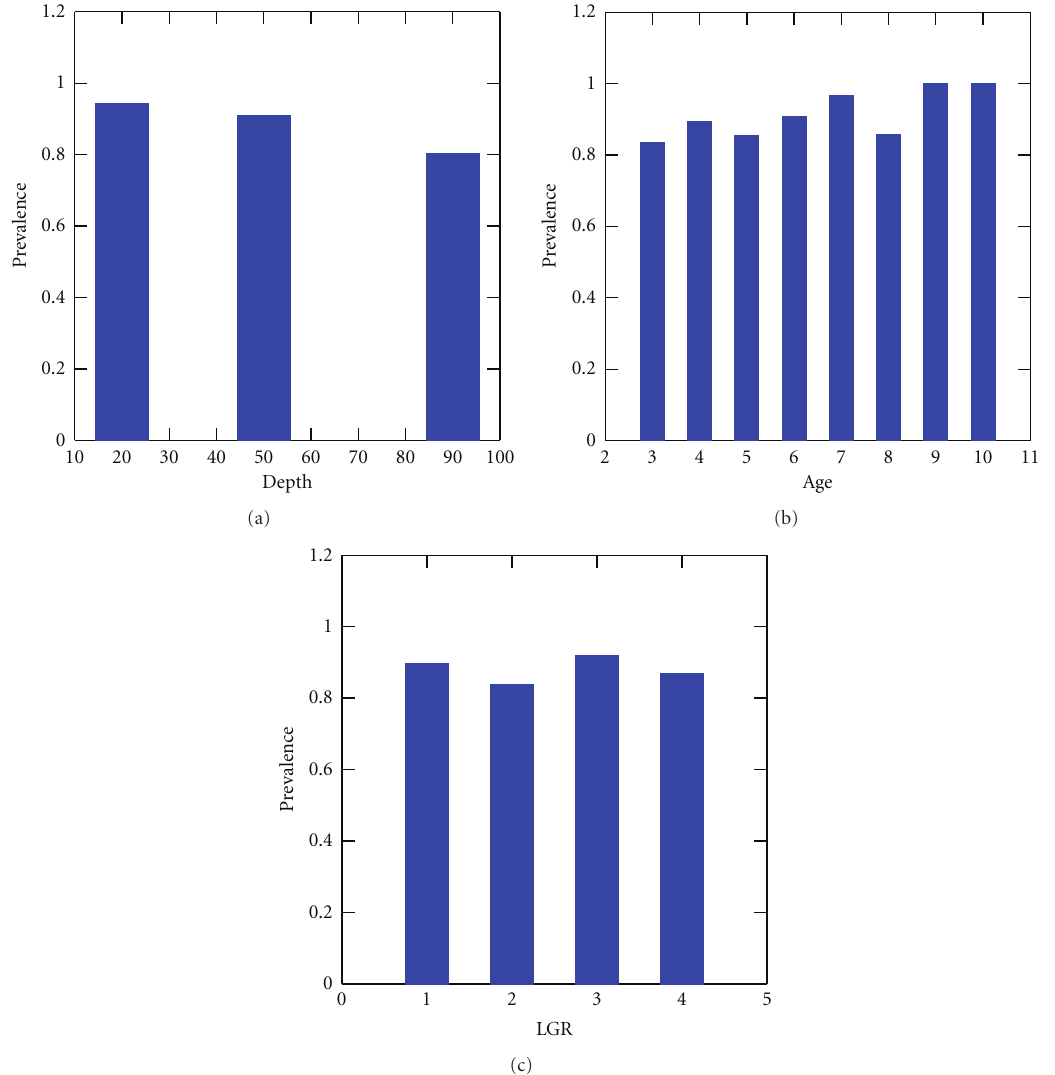
Figure 2: Prevalence of sealworm larvae ( Pseudoterranova sp. (p)) in cod ( Gadus morhua ) in relation to length-groups of fish ((1) 40–54 cm, (2) 55–59 cm, (3) 60–69 cm, and (4) > 70cm), fish-age, and seawater depth.